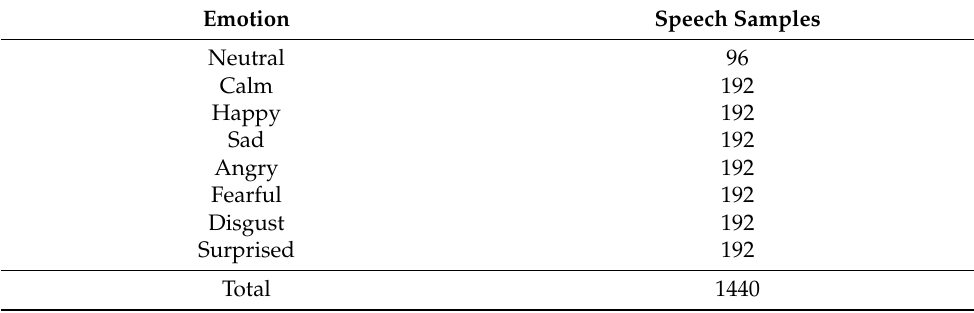
Table 1. RAVDESS Dataset Speech